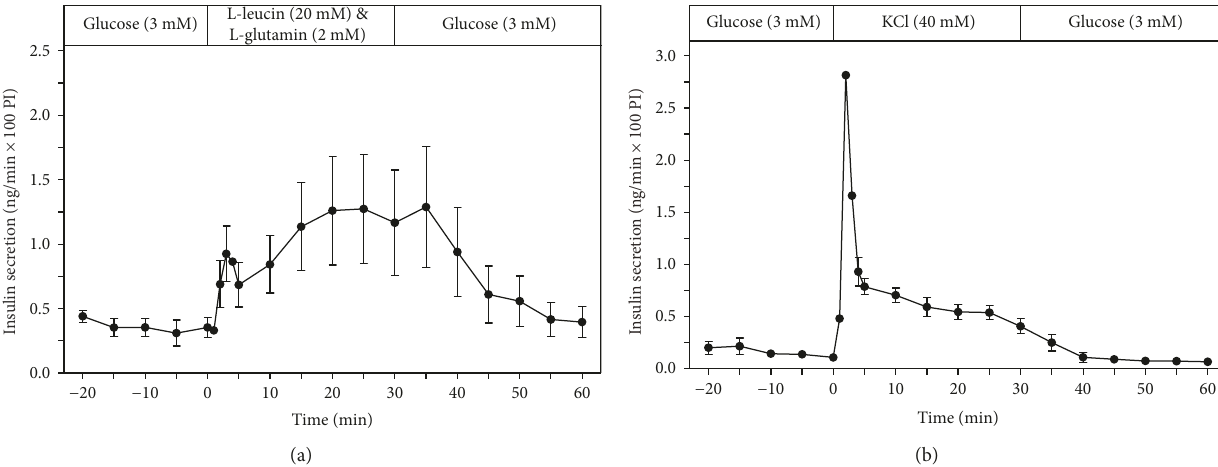
Figure 4: Kinetic pro fi les of insulin secretion from perifused EndoC- β H1 β -cell pseudoislets in response to a 30 min stimulation with leucine (20 mM) in the presence of glutamine (2 mM) (a) ( n = 4 ) as well as with KCl (40 mM) (b) ( n = 4 ). After a 20min preperifusion phase with basal glucose (3 mM), a 30 min stimulation period and thereafter a return of the perifusion to basal glucose medium for another 30 min are depicted. Shown are means ± SEM of insulin release rates expressed as ng/min and per 100 pseudoislets (PI).